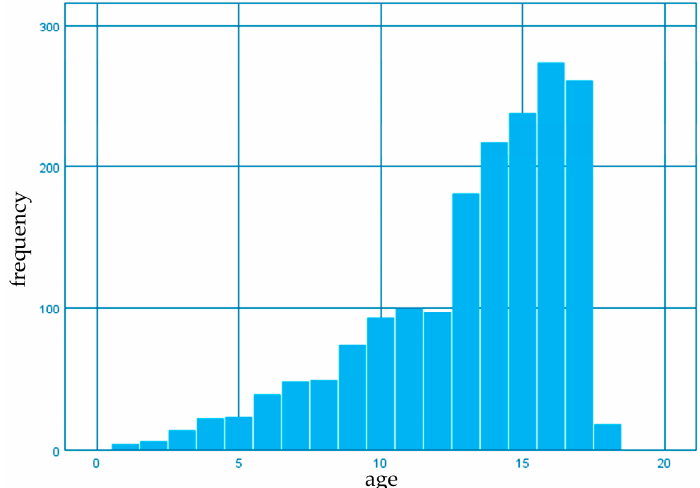
Figure 2. Age distribution of patients with or without infection with H. pylori .